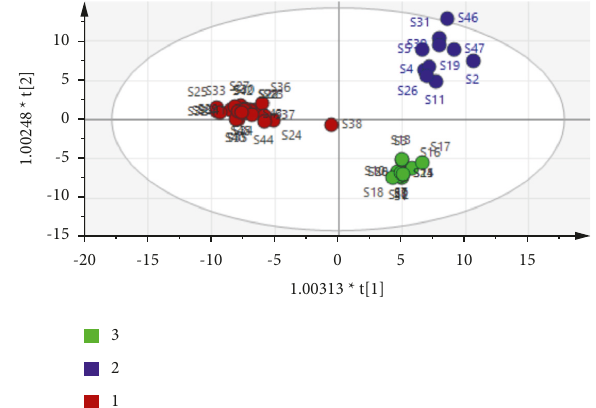
Figure 11: OPLS-DA score plot of 47 batches of Acacia catechu .